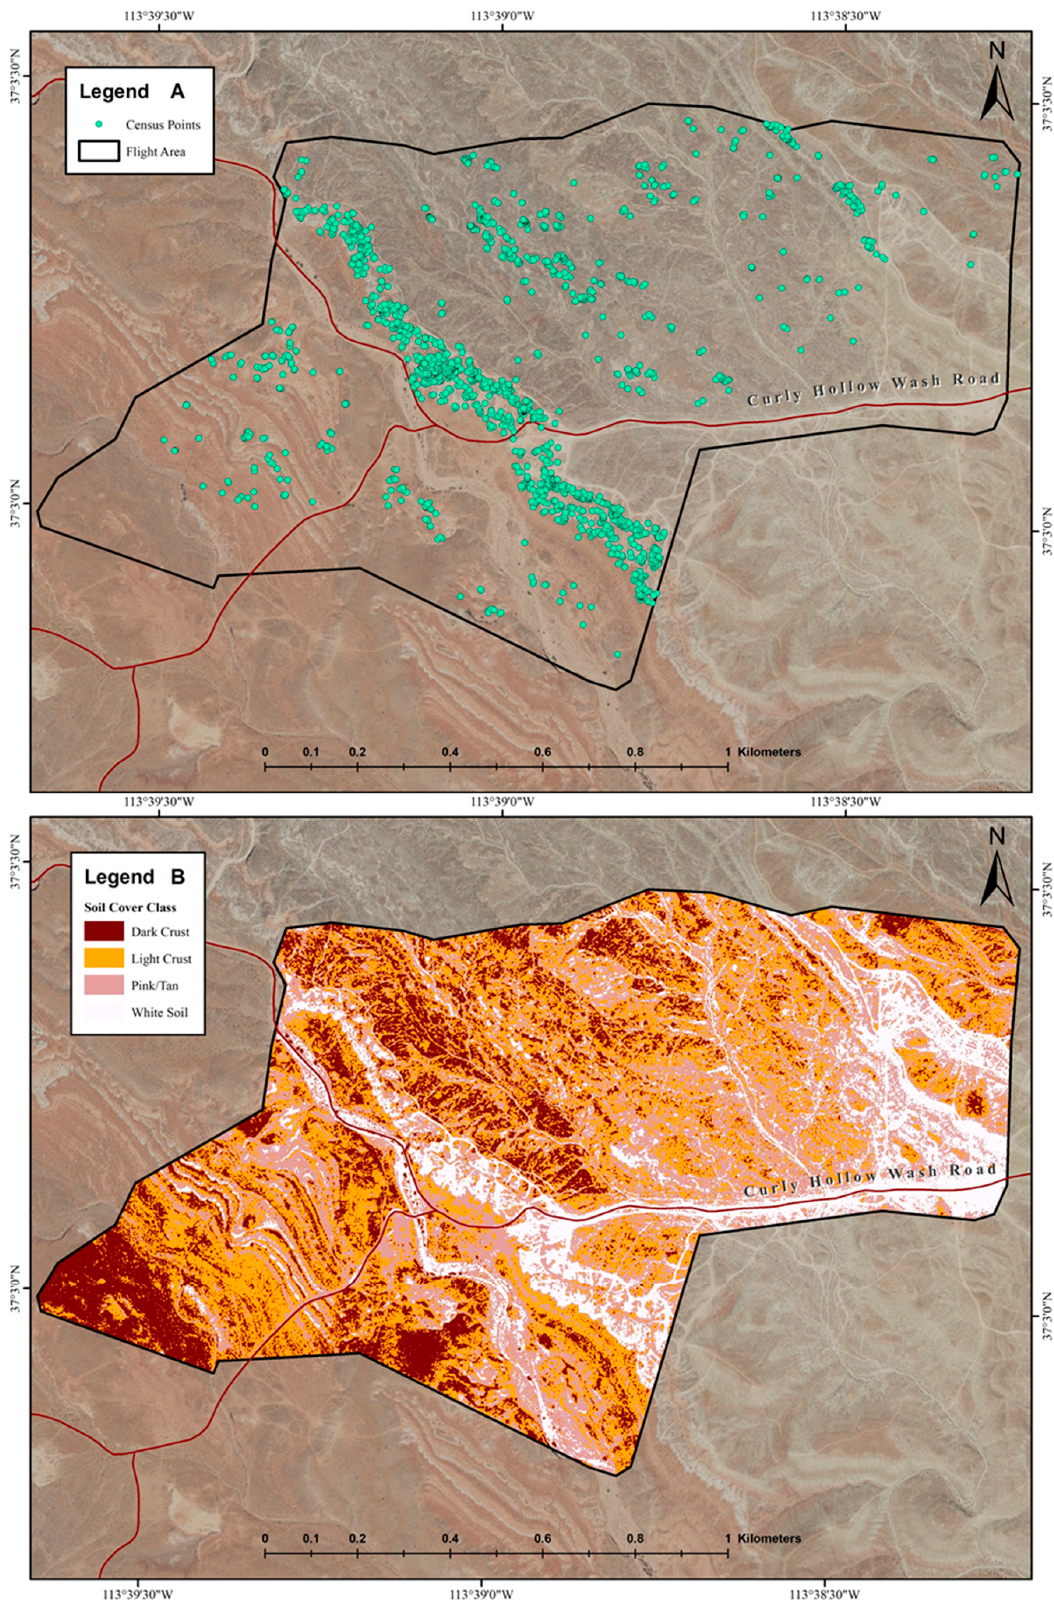
Figure 4. ( A ) Census of Tonaquint area (green points represent marked plants within the 50-m imagery) with ( B ) ISO-cluster classification of Tonaquint using 1-m NAIP imagery.